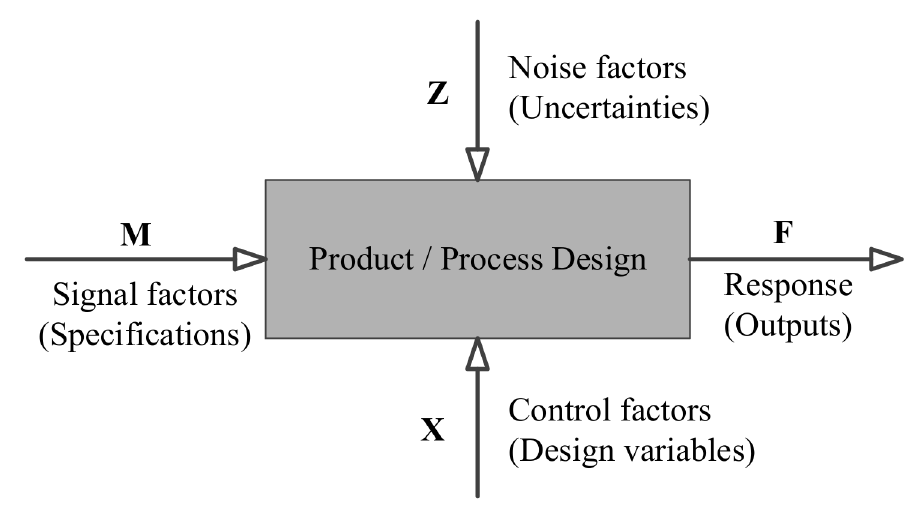
Figure 4. Block diagram of a product/process design in Taguchi method considering control factors (design variables) and noise factors